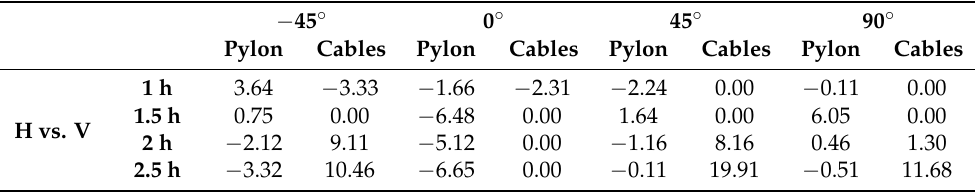
Table 6. Sensibility analysis for photographs taken horizontally (H) or vertically (V).